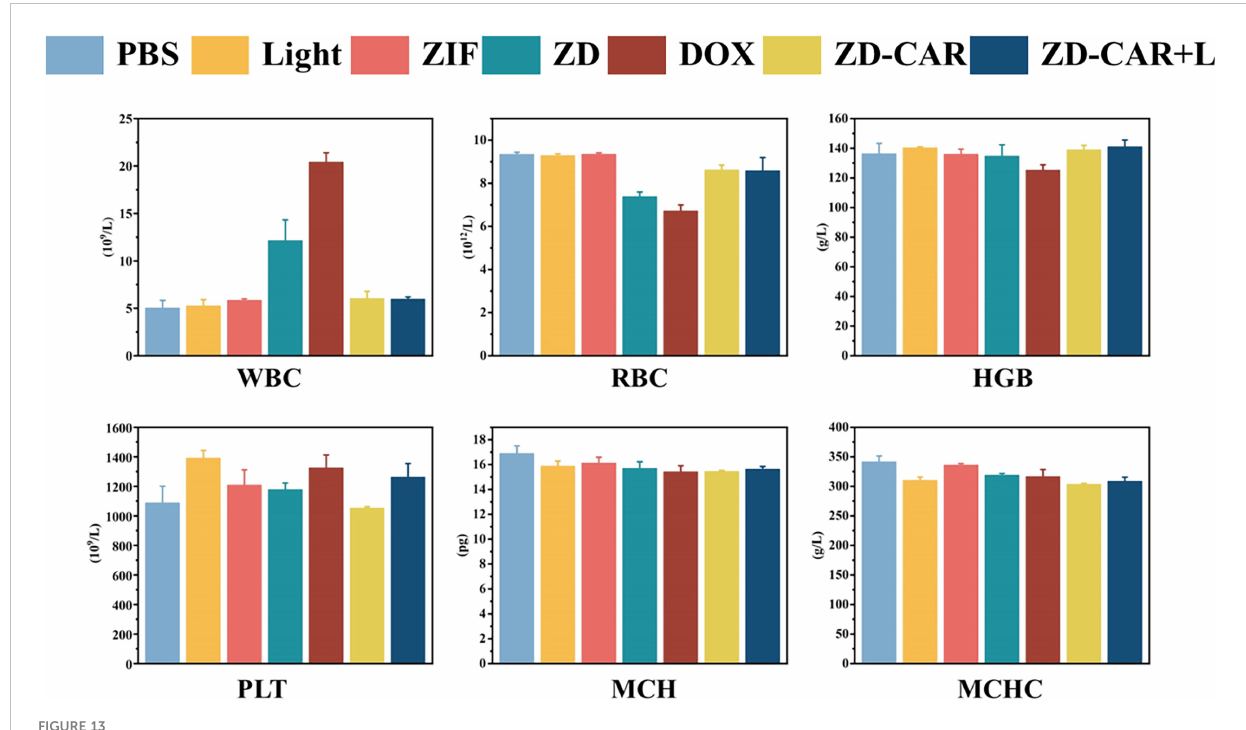
FIGURE 13 Routine blood tests of mice treated with different